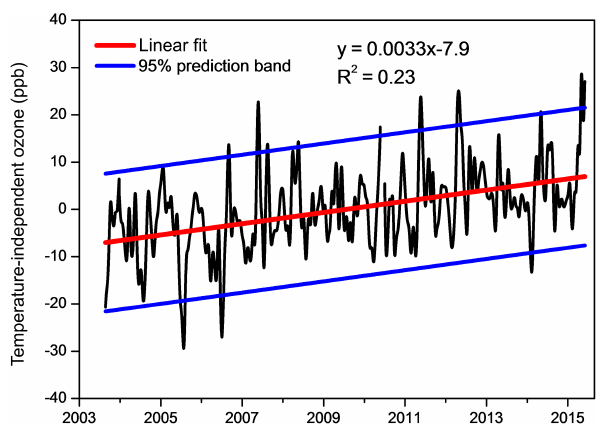
Figure 7. Time series of the noise-free and temperature- independent ozone. The red line is a linear fit and the blue lines are the 95% confidence prediction band.